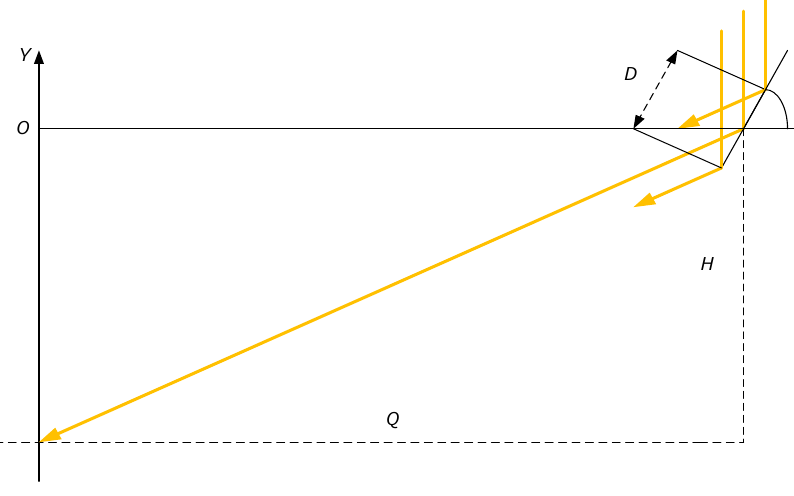
Figure 4. Structure of mirror.